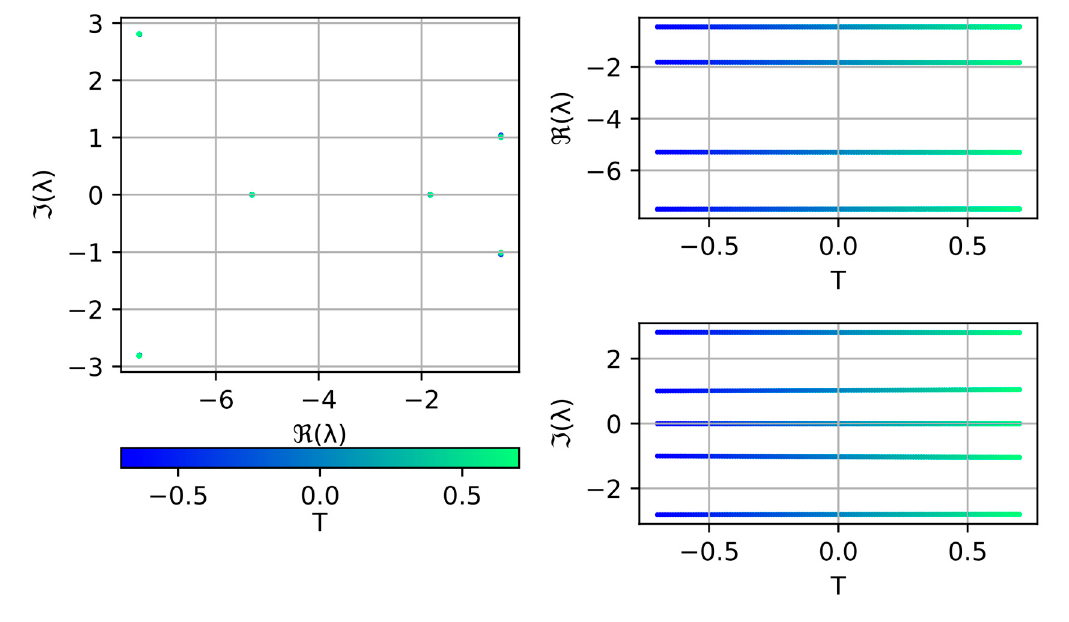
Figure 3. Poles placement of the observer in the function of the rotor flux module under nominal rotor speed and torque T = 0.35.